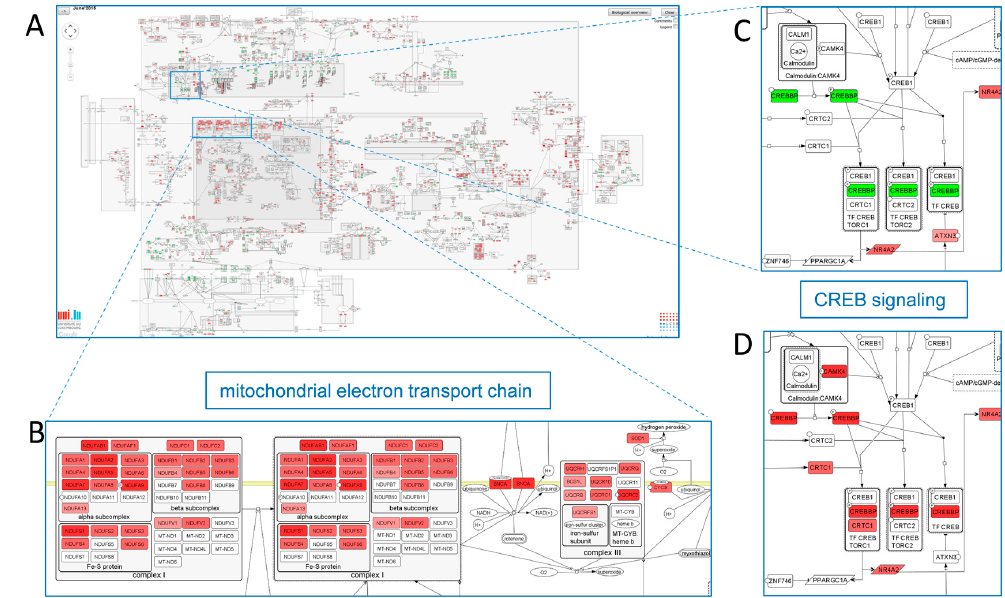
Figure 4. Data upload to Parkinson´s disease (PD) map (June 2015 release). ( A ) Differential gene expression (false-discovery-rate (FDR) < 0.05) from a meta-analysis of eight transcriptome data sets, comparing human post-mortem brain samples from PD vs. healthy controls displayed on the full PD map [95]; ( B ) Section of the mitochondrial electron transport chain; ( C ) Section of the cAMP responsive element binding protein (CREB) signaling pathway; ( D ) Age-dependent differentially expressed genes from healthy aging brain [98]. Section of the CREB signaling pathway. Color-code: green = up regulation, red = down regulation.